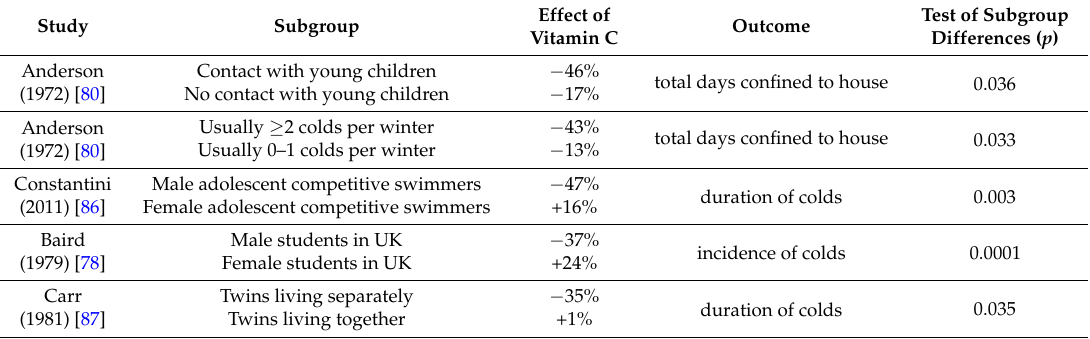
Table 5. Possible differences in the effects of vitamin C on the common cold between subgroups. Study Subgroup